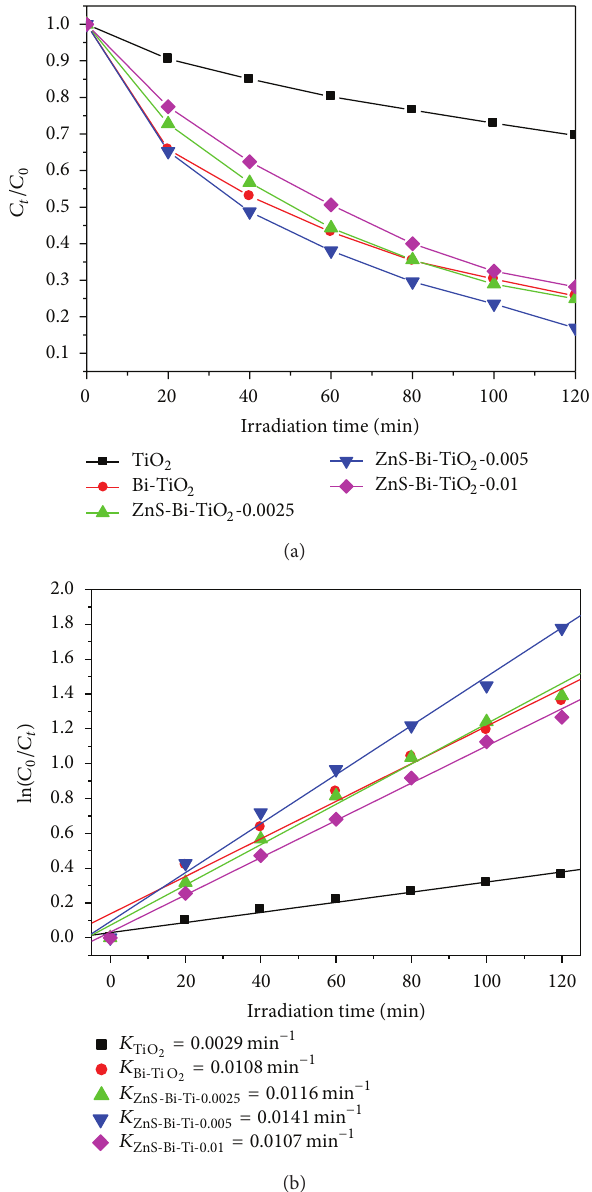
Figure 6: MO concentration (a) and ln( 𝐶 0 /𝐶 𝑡 ) (b) versus time in photocatalytic